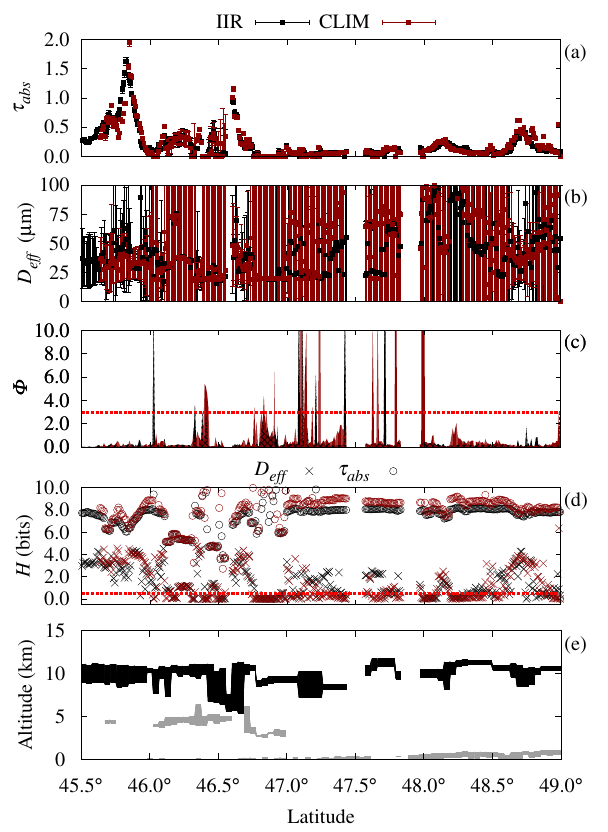
Fig. 5. Similar to Fig. 1, for 25 May 2007.